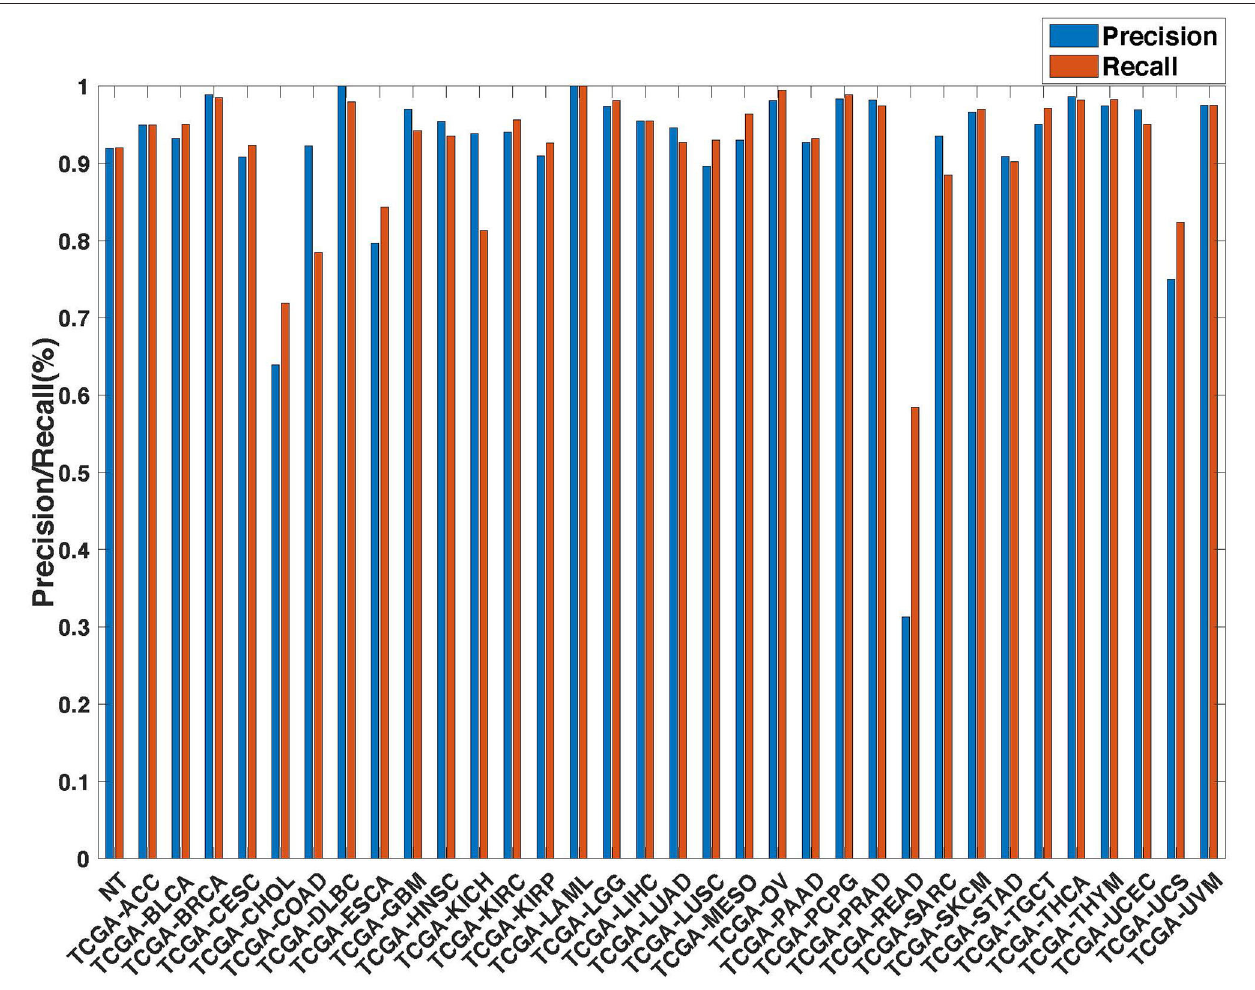
FIGURE 5 | Precision (blue) and recall (red) of the co-expression GCNN models trained with combined 33 different cancer types and normal